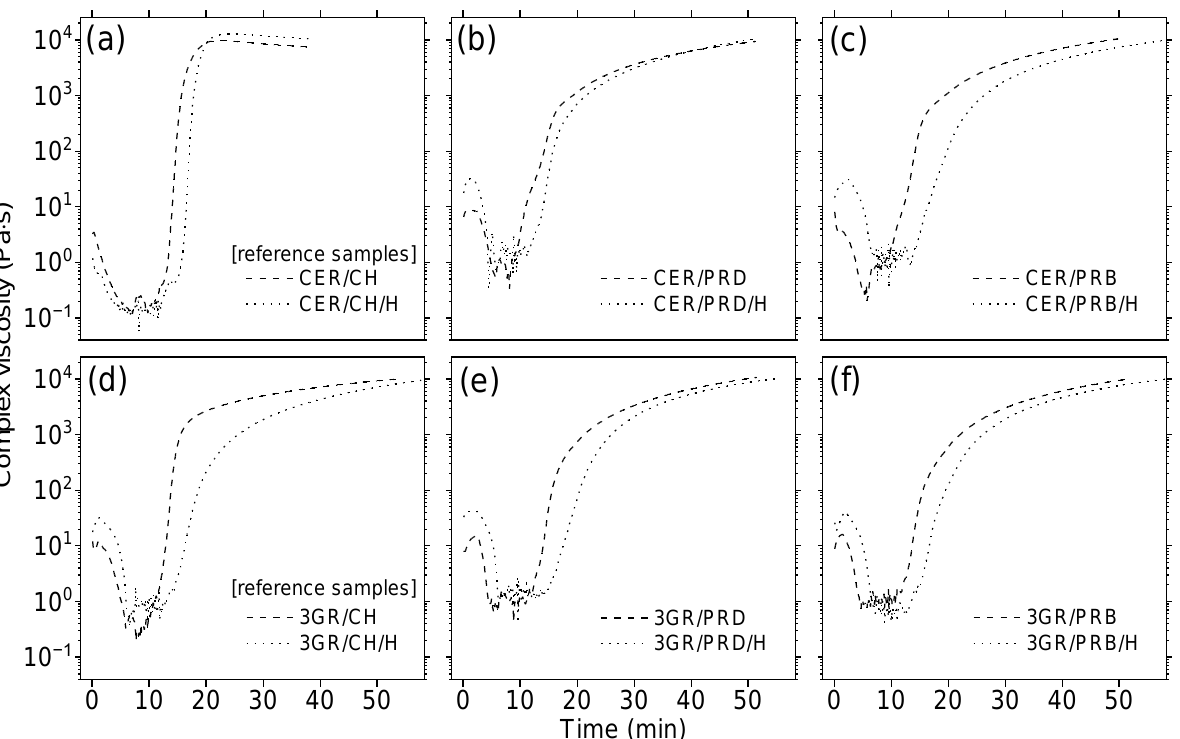
Figure 3. Rheological curves of the reference sample ( a , d ) and prepared coating composition ( b , c , e , f ) curing processes involving heating from 90 to 200 °C (heating rate 10 °C/min) followed by the reaction under isothermal conditions (200 °C). Symbols are explained in Table 2.